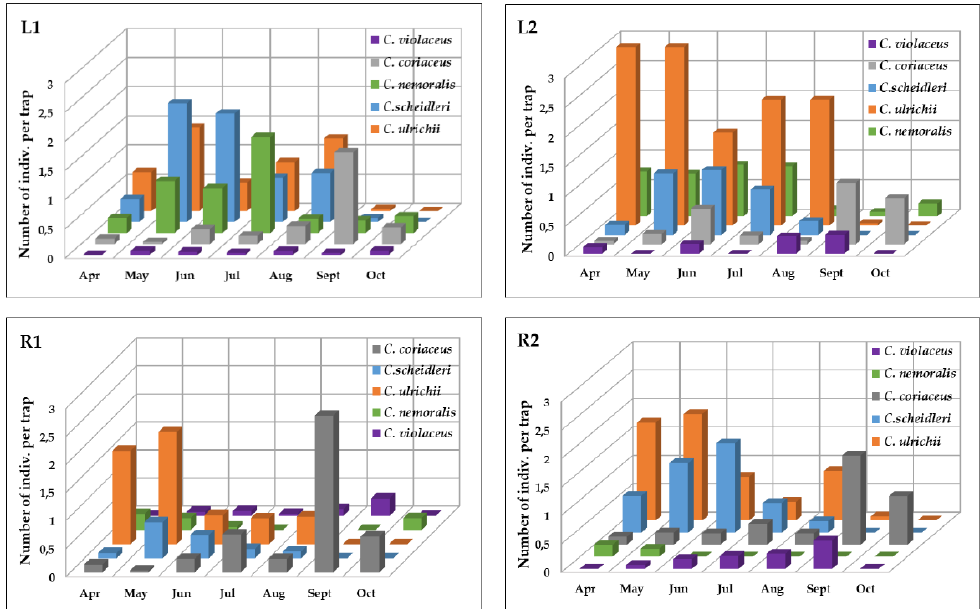
plots in 2018. Two forest stands: L1—close-to-nature forest plot; L2—managed forest plot. Two stands after logging operations 10 years ago: R1—recovering indigenous tree species plot; R2—alien Ailanthus altissima